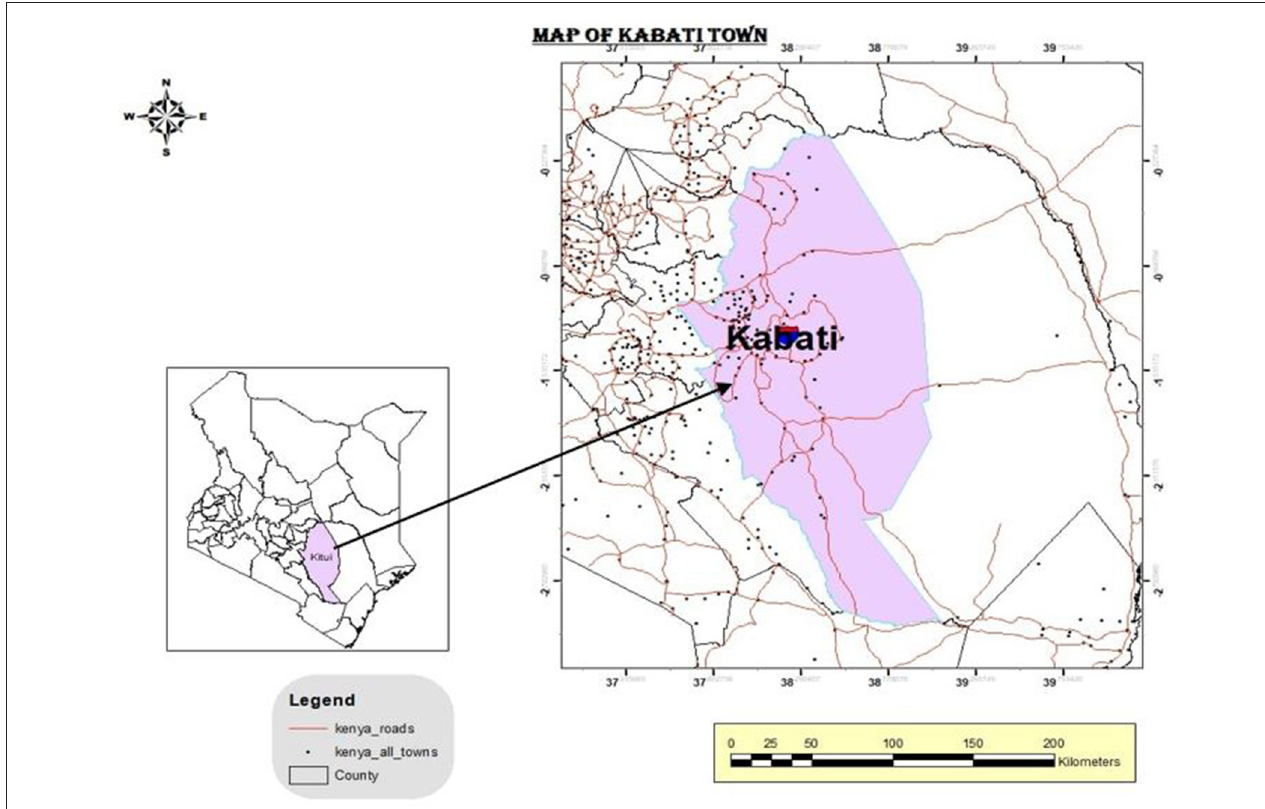
FIGURE 1 | Location of Kabati, in Kitui County, Kenya (Source; author generated).